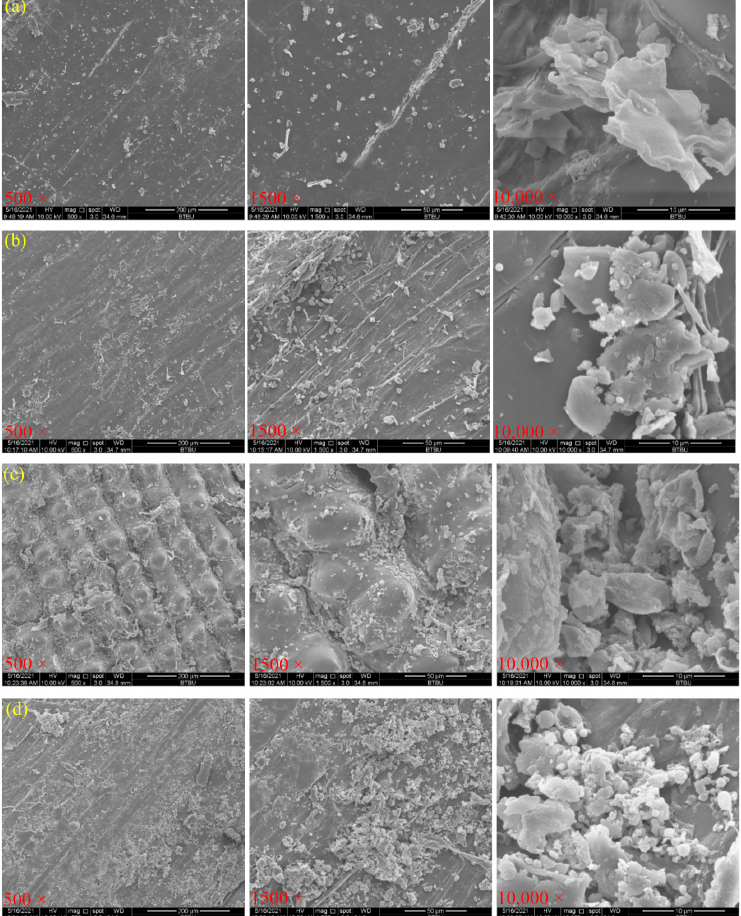
Figure 8. Scanning electron microscope image of rice hulls ( a ), Jiuzao ( b ), Jiuzao after autohydrolysis treatment ( c ), and Jiuzao after autohydrolysis and enzymatic hydrolysis treatment ( d ) at different